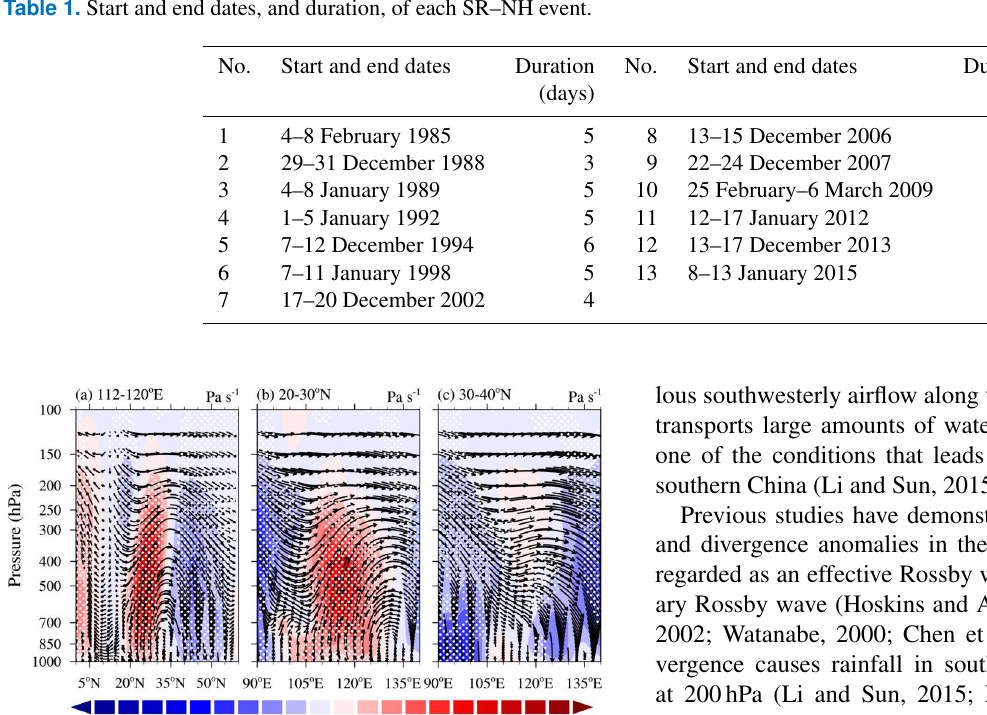
Table 1. Start and end dates, and duration, of each SR–NH event.